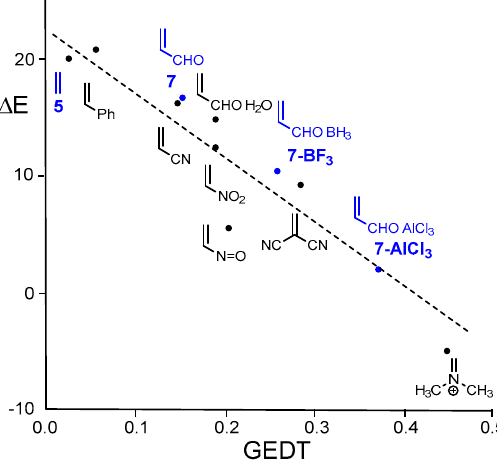
Figure 1. Plot of the activation barriers ( △ E in kcal·mol − 1 )) vs. the global electron density transfer (GEDT), e, R 2 = 0.89, for the Diels–Alder reactions of Cp 1 with the substituted ethylene series of an increased electrophilic character.